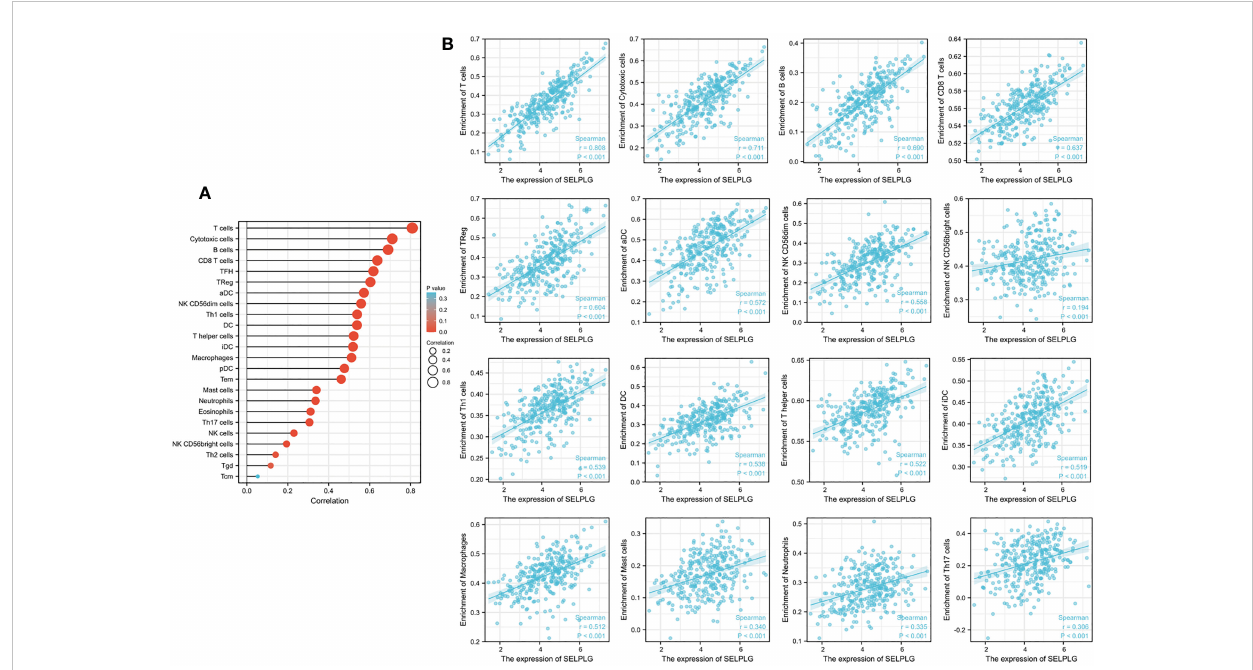
FIGURE 4 Correlation of PSGL-1 expression with immune in fi ltration in cervical cancer. (A) Correlation between the expression of PSGL-1 and the abundance of TILs in cervical cancer. (B) Correlation of PSGL-1 expression with in fi ltration levels of T cell, cytotoxic cell, B cell, CD8+ T cell, T-cell regulatory, aDC, NK CD56dim cells, NK CD56bright cells, Th1cells, DC, T helper cells, and aDC in cervical cancer available at TIMER2.0 database. TILs, tumor- in fi ltrating lymphocytes; TIMER2.0, Tumor Immune Estimation Resource. Color images are available online.